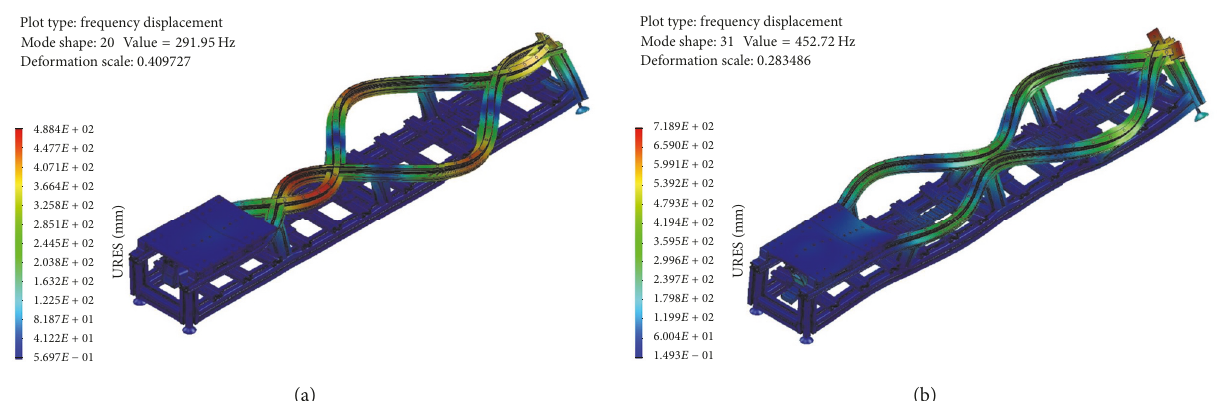
Figure 15: Mode shapes for transversal opposite waves on top lateral bars in position P5: (a) 3rd-order mode (#20) ( 𝑓 ≈ 292 Hz, def. scale = 0.409); (b) 4th-order mode (#31) ( 𝑓 ≈ 453 Hz, def. scale ≈ 0.283).